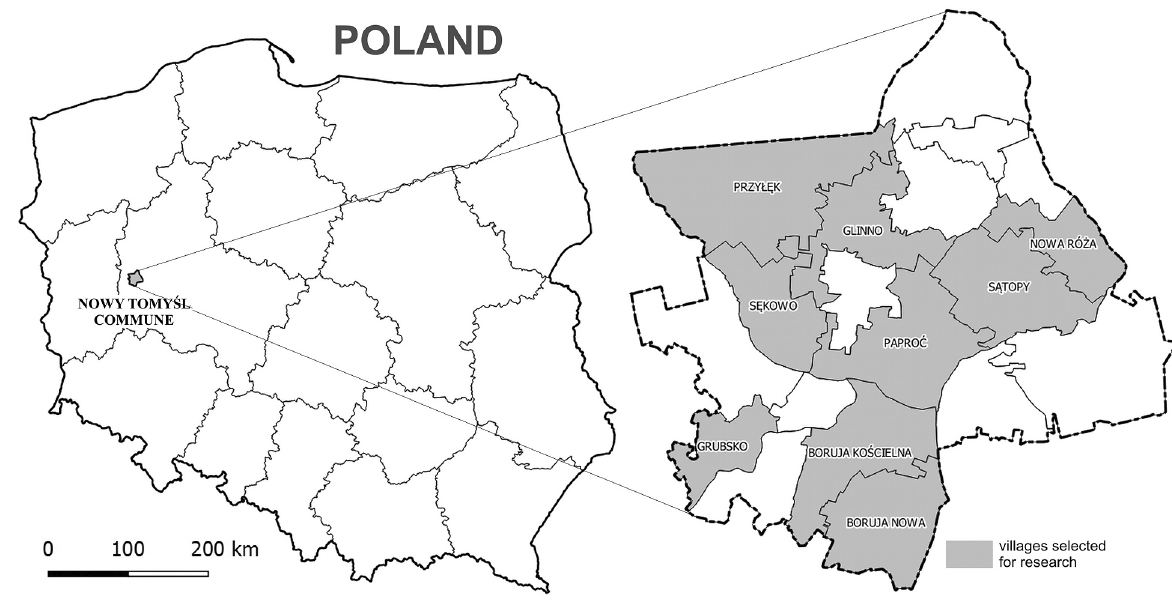
Fig. 1. Location of the study